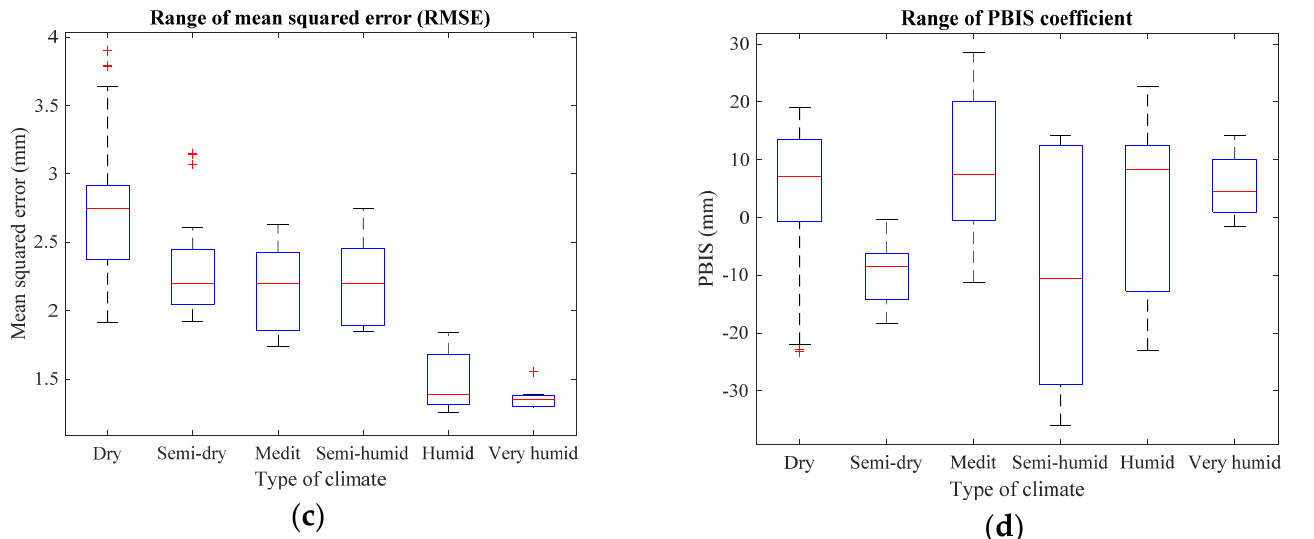
Figure 9. Box plots of statistical coefficients obtained in validation of the two novel methods using data from 32 synoptic weather stations in Iran. ( a ) Range of correlation coefficient (R); ( b ) Range of Nash coefficient (NSE); ( c ) Range of mean squared error (RMSE); ( d ) Range of PBIS Table 4. Range of values of statistical indicators obtained in validation of the two novel methods with the two-parameter input combination using data from 32 synoptic weather stations in Iran.